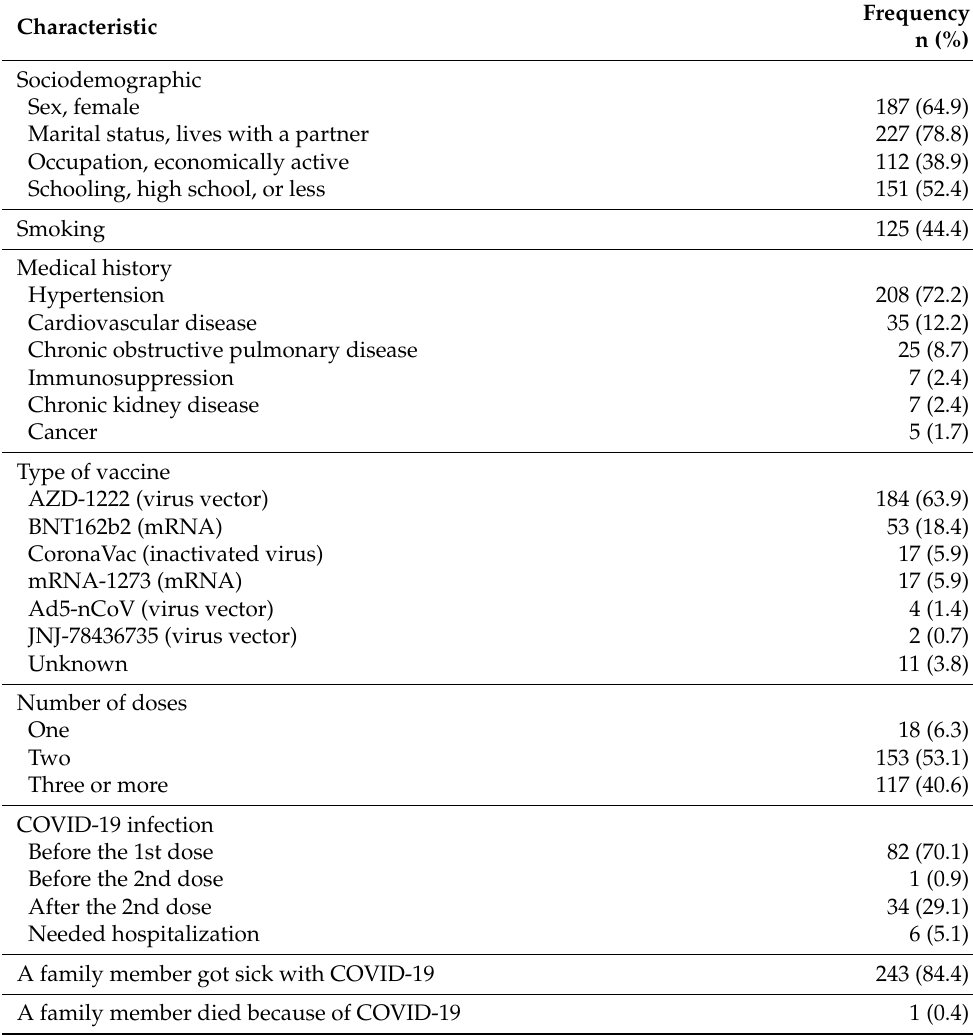
Table 1. Sociodemographic, smoking, medical, and COVID-19 history in patients with type 2 diabetes with at least one dose of vaccine against COVID-19 (n =